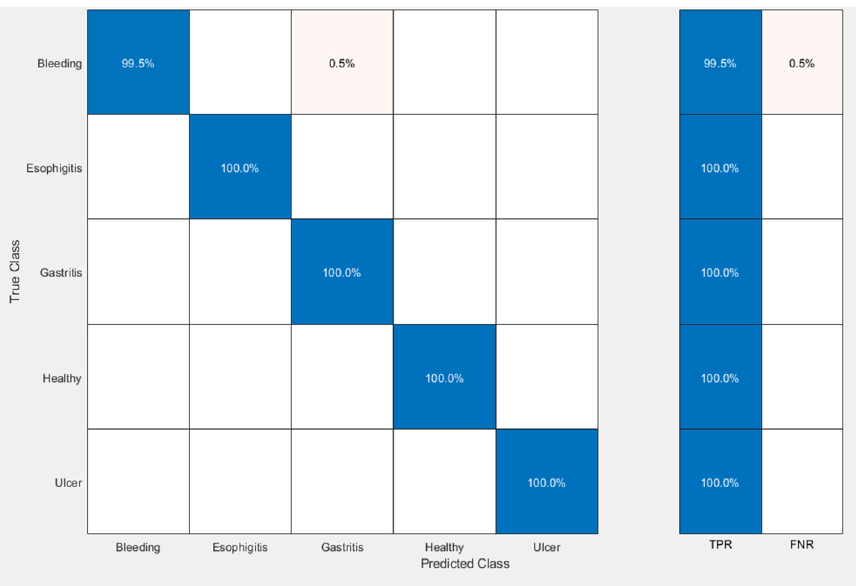
Figure 6. Confusion matrix (true positive rates) of cubic SVM using fused features.